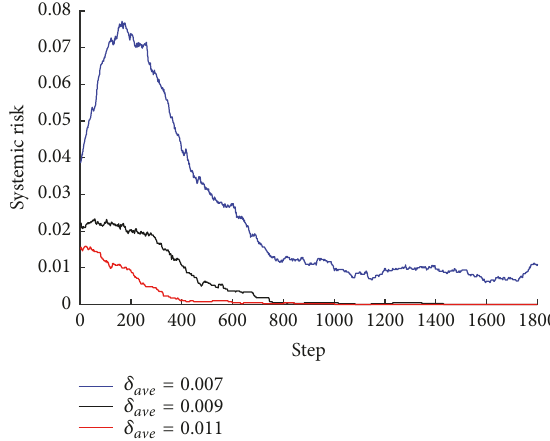
Figure 5: Systemic risk under different values of 𝛿 𝑎 V 𝑒 . The parame- ters are set as 𝑑 = 0.0533 , 𝜃 = 0.04 , 𝑝 = 0.05 , 𝐶 = 0.03 , 𝜎 𝐴 = 0.15 , = 0.25 , 𝐴 = 1000 , 𝑤 = 500 𝜒 = 0.3 , 𝛽 = 0.25 , 𝑁 = 200 , 𝑀 = 150 , 𝜎 𝑤 𝑟 = 0.004 , and 𝑟 = 0.008 𝑎 𝑏